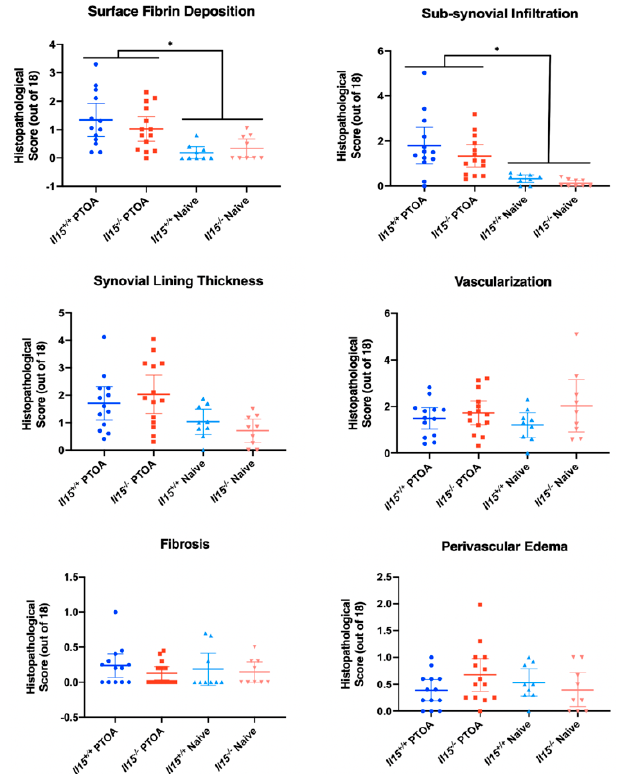
Figure 9. Synovitis is not significantly different between Il15 +/+ PTOA and Il15 − / − PTOA rats. Rats either underwent ACLT-DMM surgery to induce PTOA or served as control with no surgery (Naive). Semi-quantitative scoring was used to assess synovitis across 6 parameters, ranging from 0 (none) to 3 (severe), measured in 6 zones (medial and lateral parapatellar, superior, and inferior compartments). A one-way ANOVA with Tukey’s multiple comparison test or the Kruskal–Wallis with Dunn’s multiple comparison test was run, depending on normality. Data represents mean with 95% CI. Analysis reveals that the PTOA group had scored significantly higher for sub-synovial infiltration and surface fibrin, although there was no significant difference between genetic strains. The remaining 4 parameters were non-significant across all groups (* p < 0.05, N = 15 rats/PTOA group and 9 rats/Naive group).